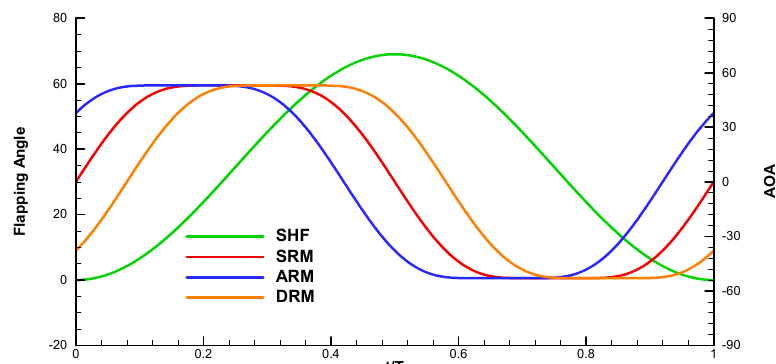
Figure 4. The time histories of flapping (green) and relative AOA angles in one period during hovering motion. (SHF: simple harmonic function; AOA: angle of attack; SRM: symmetrical rotation mode; ARM: advanced rotation mode; DRM: delayed rotation mode. Units of flapping angle and relative AOA are